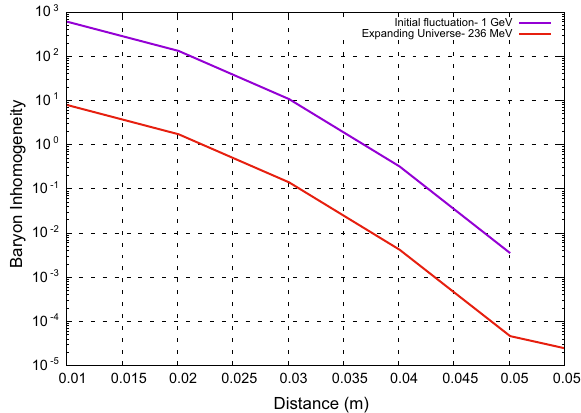
Fig. 5 The decay of the fluctuation is shown in log scale between 1 GeVand236MeVforaplasmawhereaquarkismovingthroughmuons